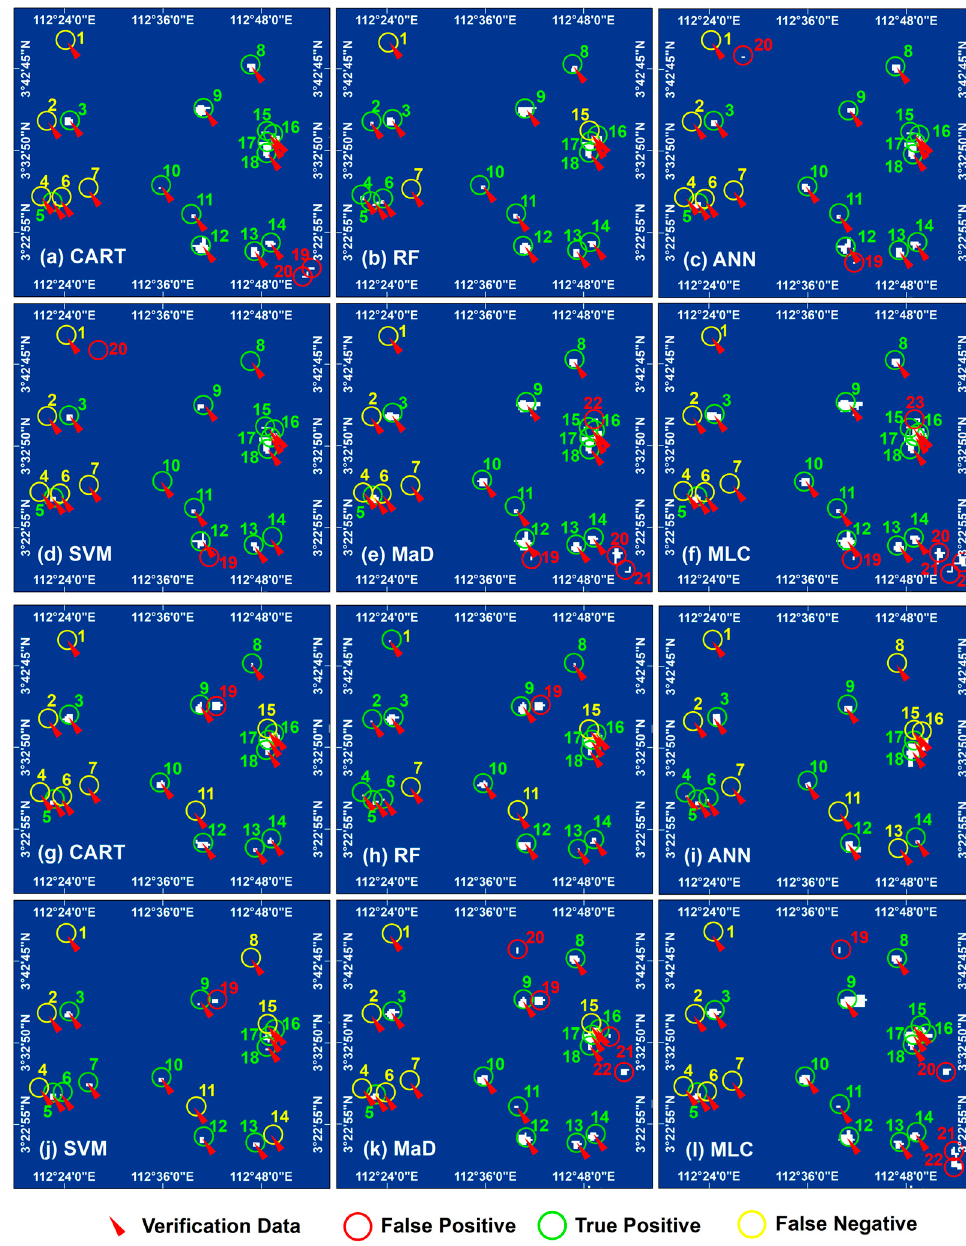
Figure 5. Extraction results of the targets in region 2, located in the Zengmu Basin: ( a – f ) are the extraction results in 2016; ( g – l ) are the extraction results in 2017. Red arrows are the validation targets; green circles are the correctly extracted targets; yellow circles are the omissive targets; and red circles are the incorrectly extracted targets.